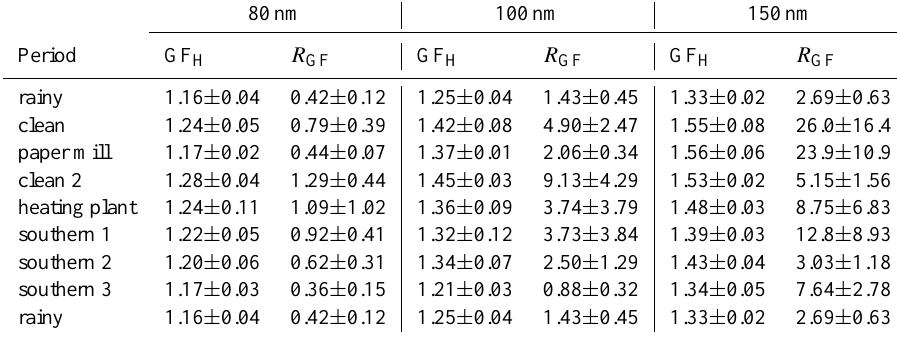
Table 8. Average values and standard deviations of particle hygroscopic growth factors GF H and the ratios between more and less